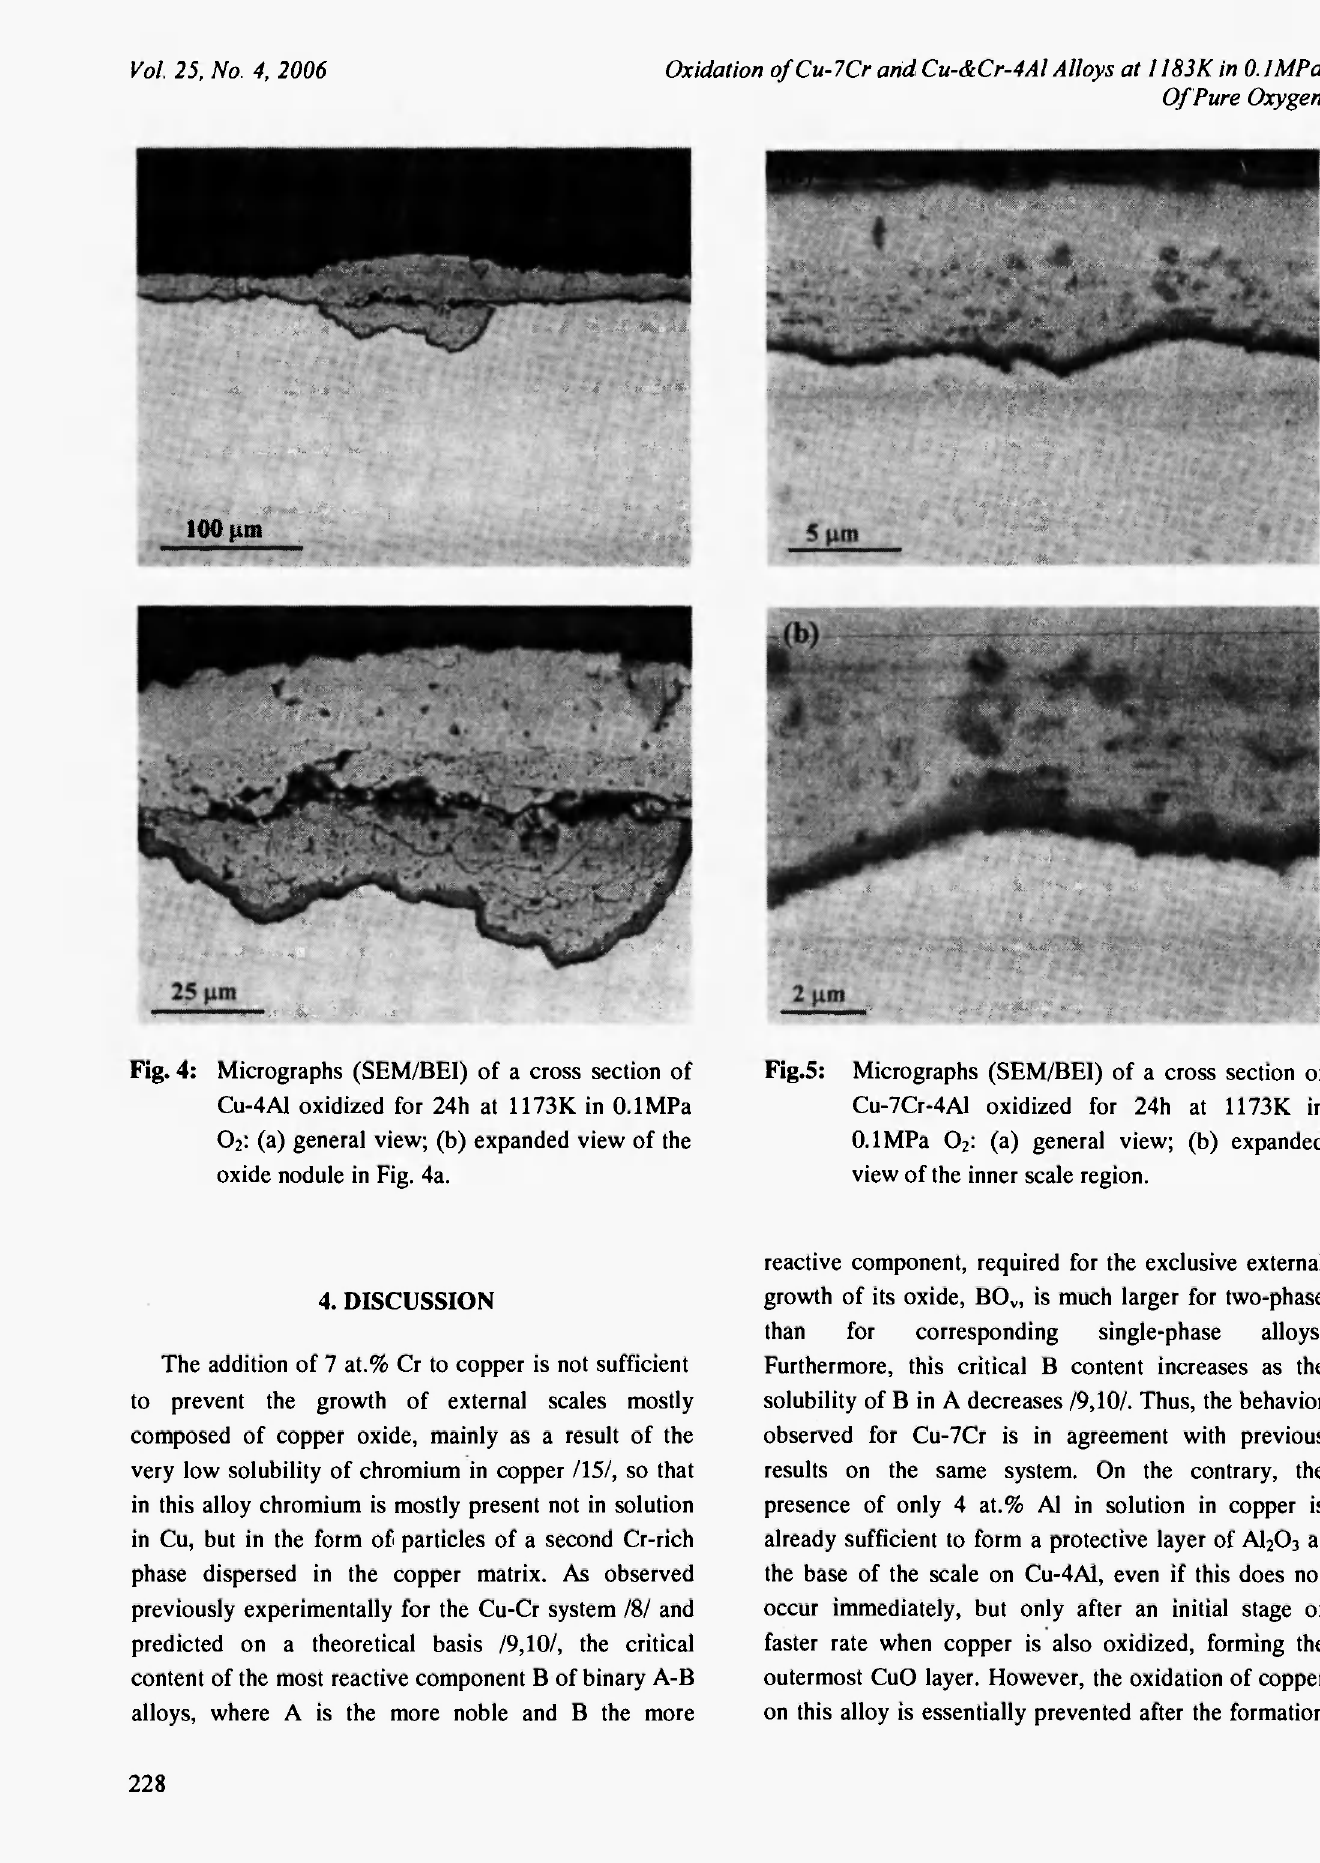
Fig. 4: Micrographs (SEM/BEI) of a cross section of Cu-4A1 oxidized for 24h at 1173K in 0.1 MPa 0 2 : (a) general view; (b) expanded view of the oxide nodule in Fig. 4a.